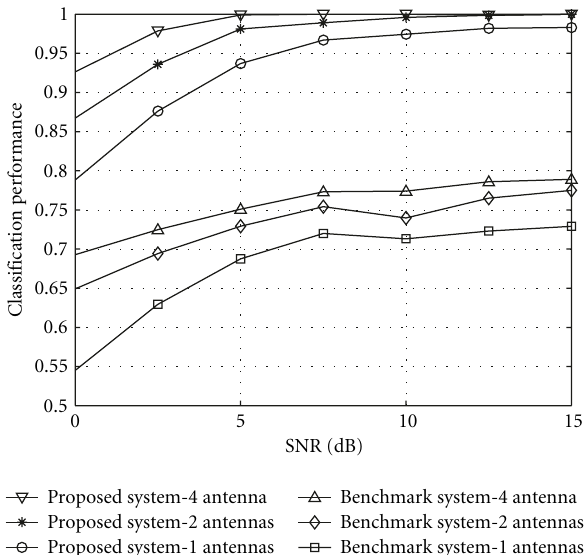
Figure 21: Ability of proposed classifier and benchmark to determine a signal’s modulation family in a faster varying 20-path fading channel using